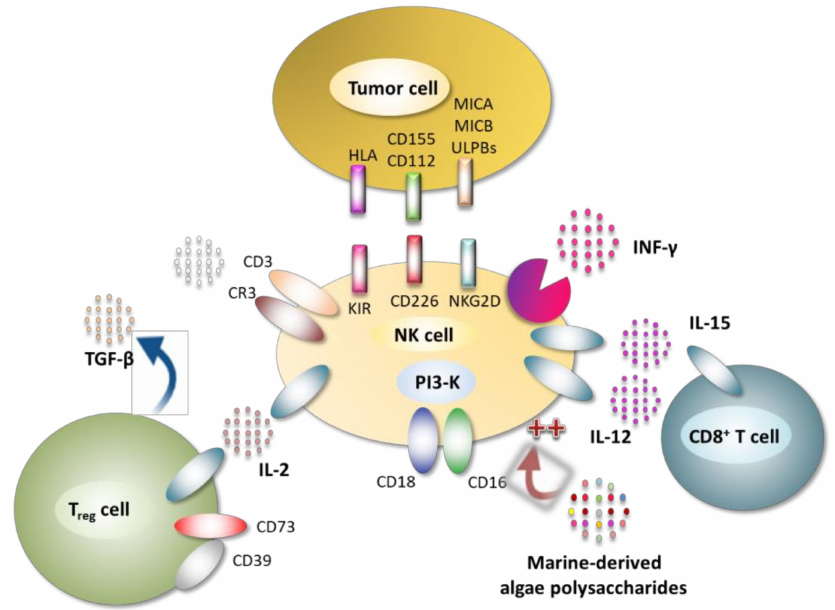
Figure 14. Signaling pathways involved in natural killer cell (NK cells) activation by bioactive algal polysaccharides.